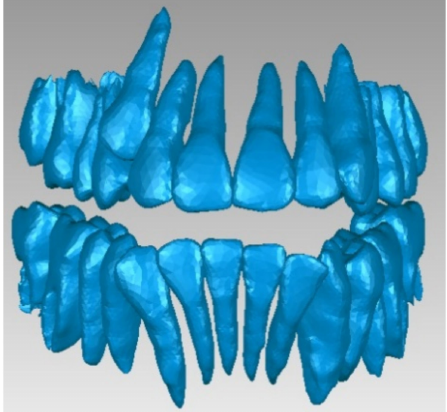
Figure 10. The final dental structure in Geomagic.